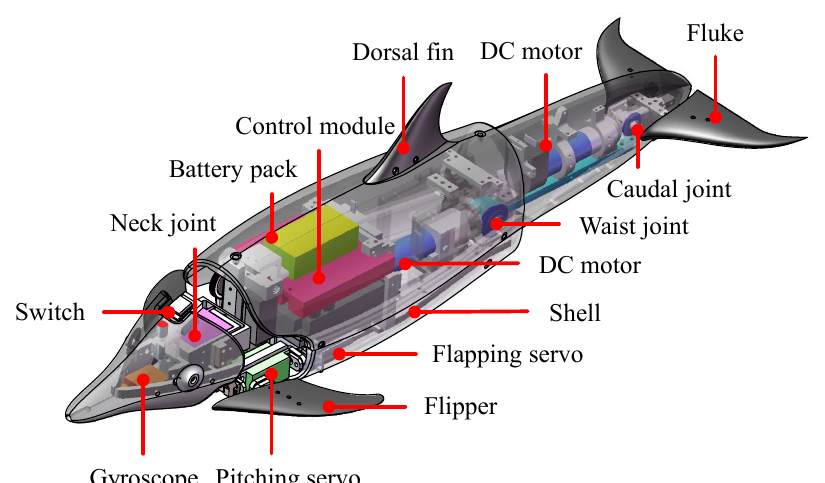
Figure 1. Mechanical design of the bionic robotic